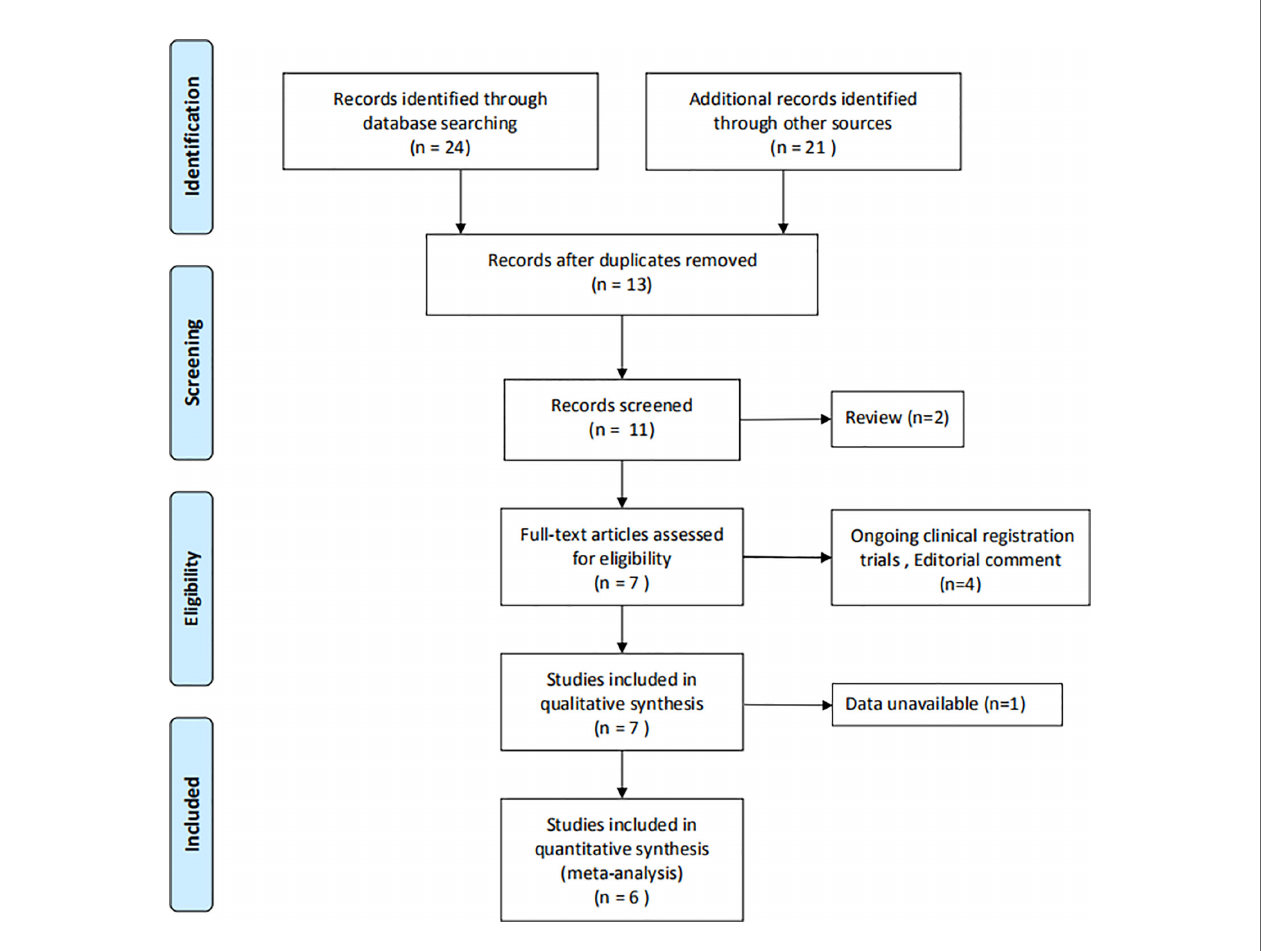
FIGURE 1 | Flowchart of